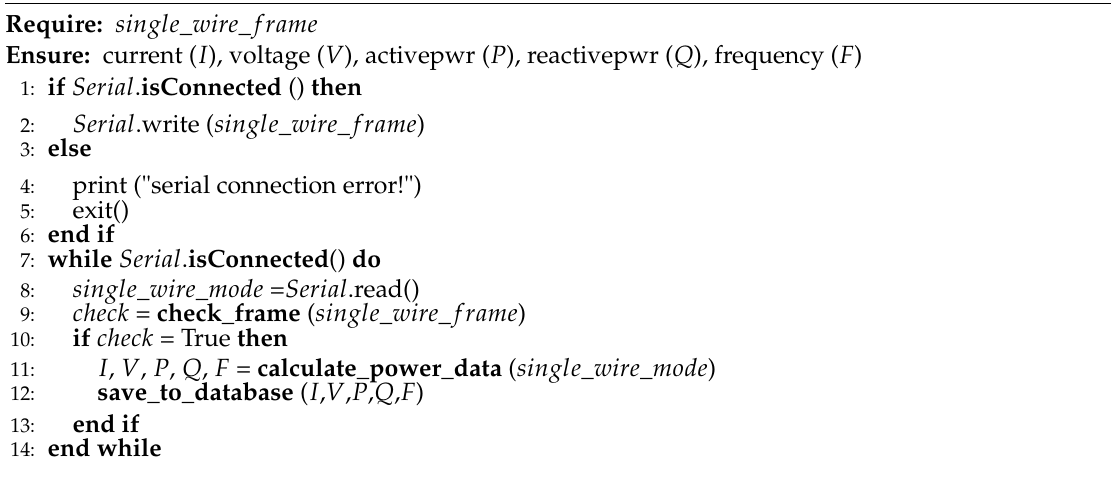
Algorithm 1 The requesting and storing energy data of Jetson